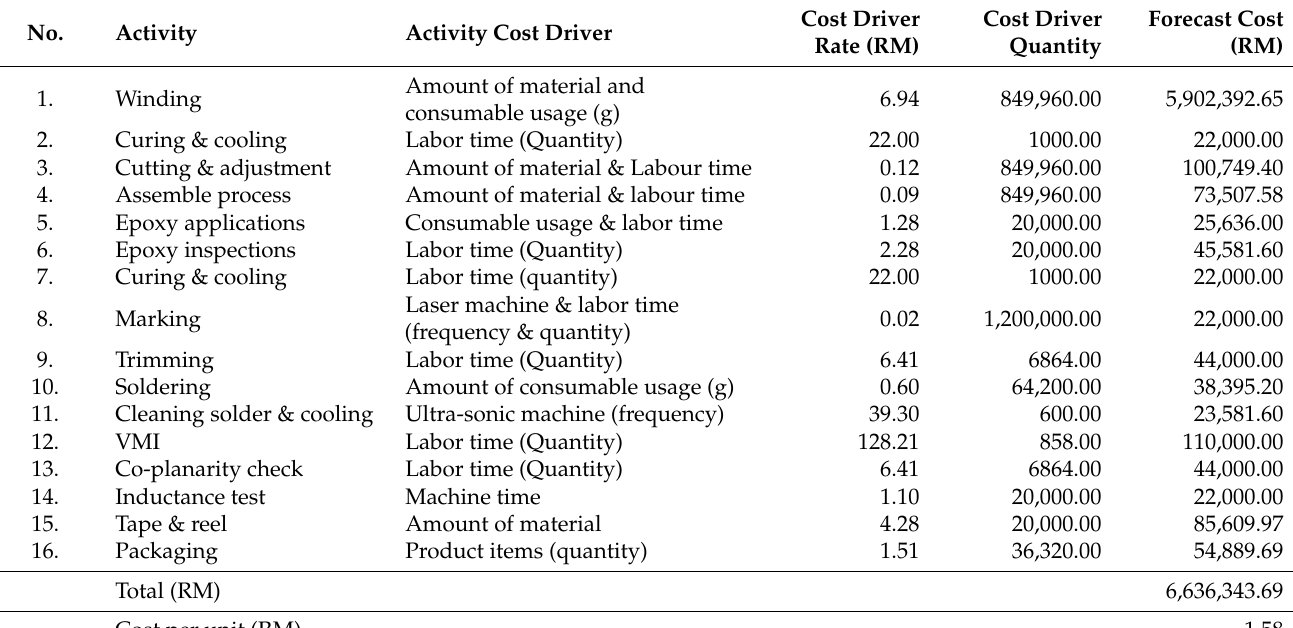
Table 3. Costing structure under integration